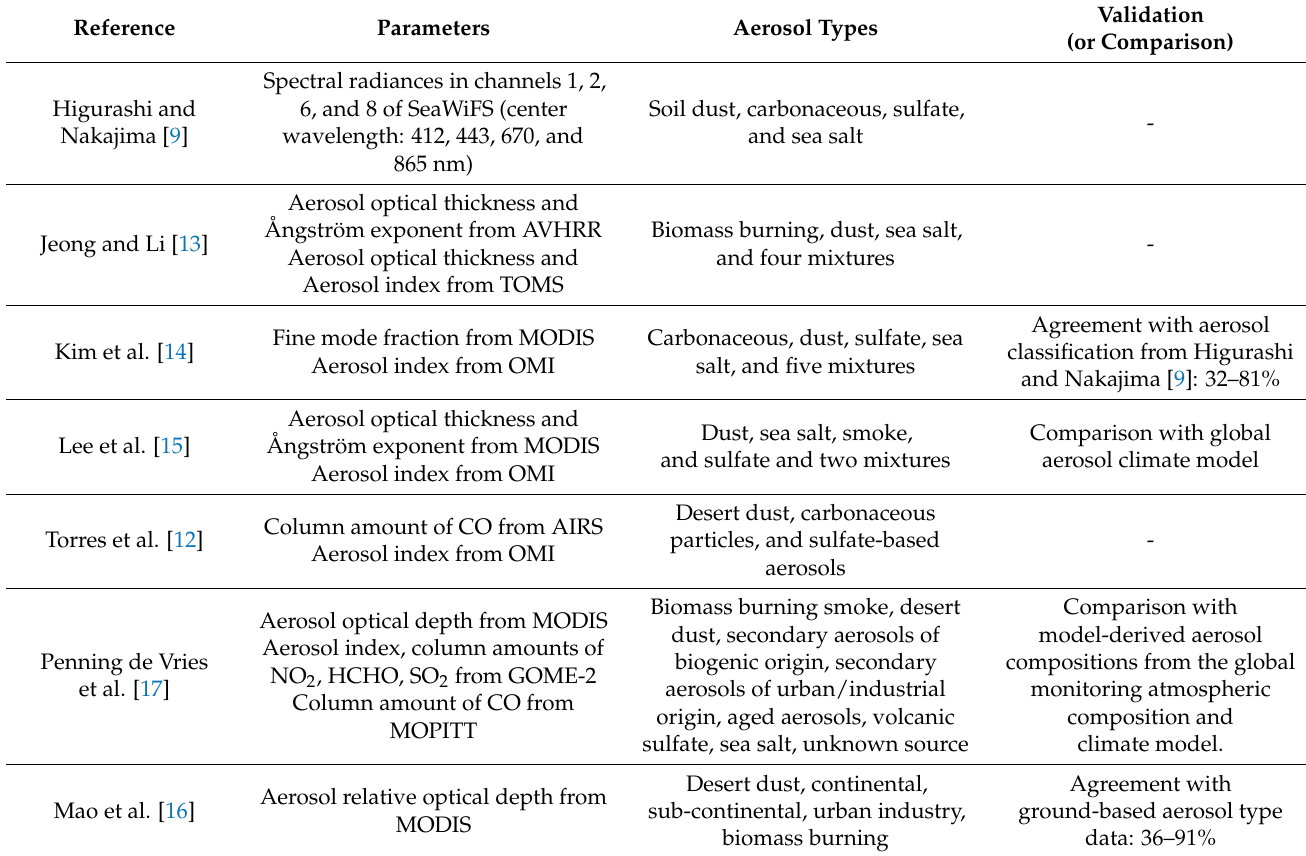
Table 1. Summary of previous studies of threshold-based satellite aerosol classification. Abbreviations: SeaWiFS, Sea- viewing Wide Field-of-view Sensor; AVHRR, Advanced Very-High-Resolution Radiometer; TOMS, total-ozone mapping spectrometer; MODIS, Moderate-Resolution Imaging Spectroradiometer; OMI, Ozone Monitoring Instrument; GOME-2, Second Global Ozone Monitoring Experiment; MOPITT, Measurements of Pollution in the